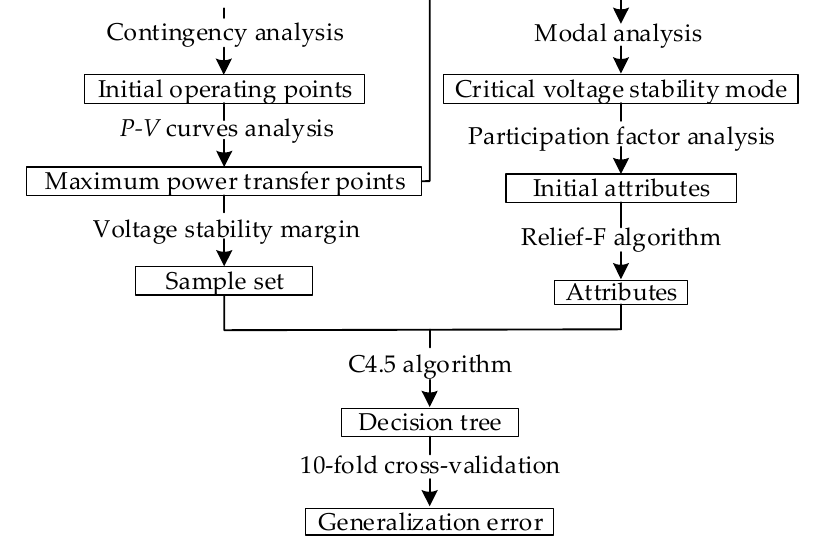
Figure 1. Framework of proposed method.